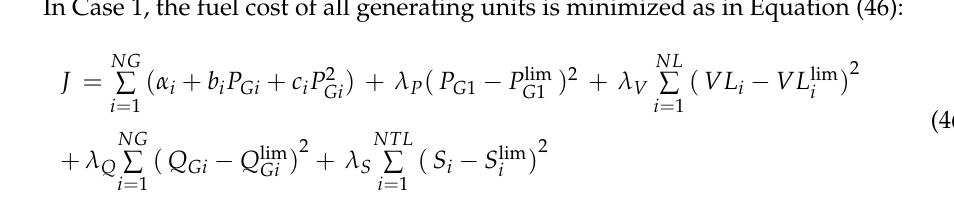
algorithm (ICA) and TLBO (teaching-learning-based optimization) (MICA–TLA) [67], adap-